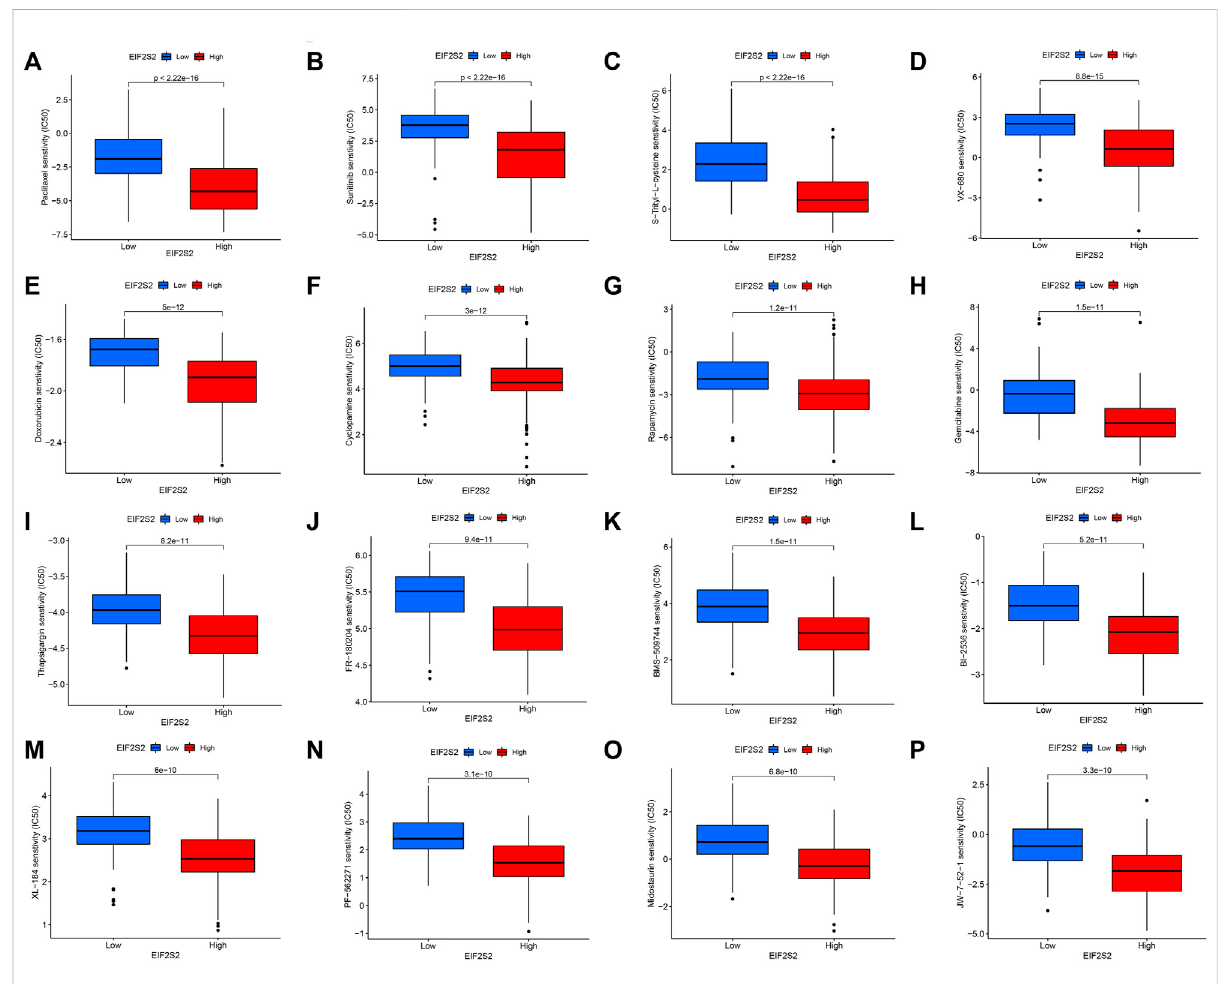
FIGURE 7 The relationship between EIF2S2 expression levels and drug